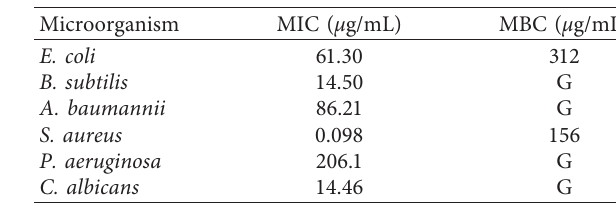
Table 5: The nonlinear regression sigmoidal dose-response curve calculated EC ABTS and DPPH free radicals.